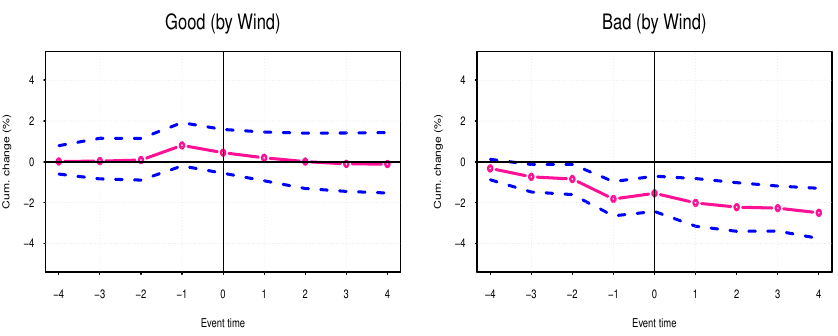
Figure 7. Extreme event on Wind and response of WTI oil.